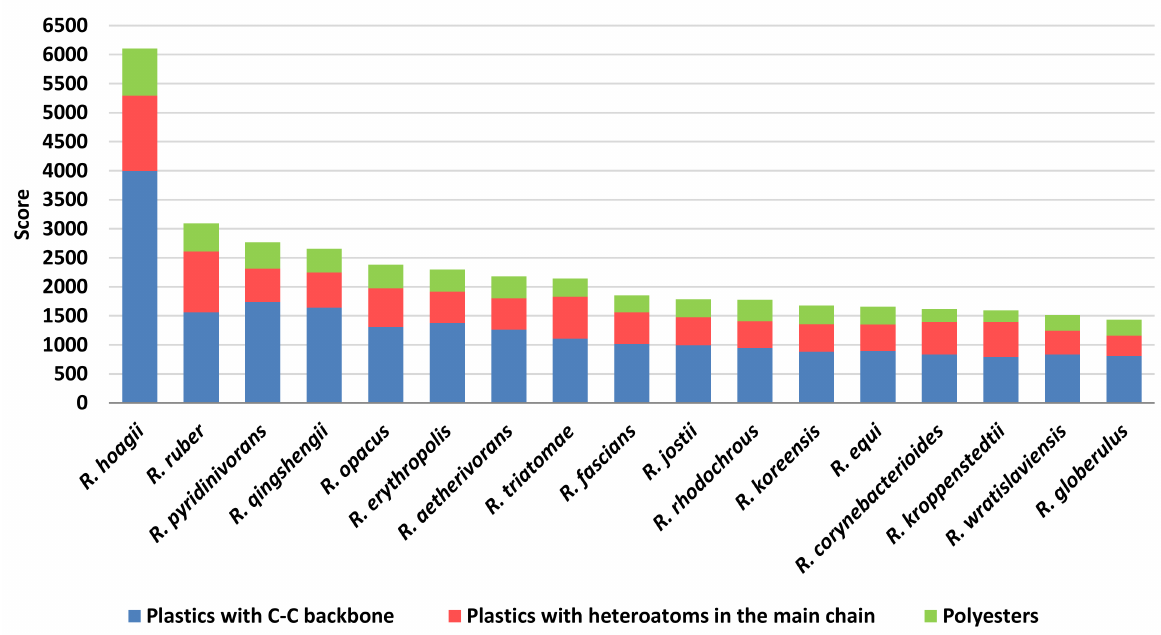
Figure 13. Score values for the most prominent Rhodococcus species for each class of diverse poly- mer